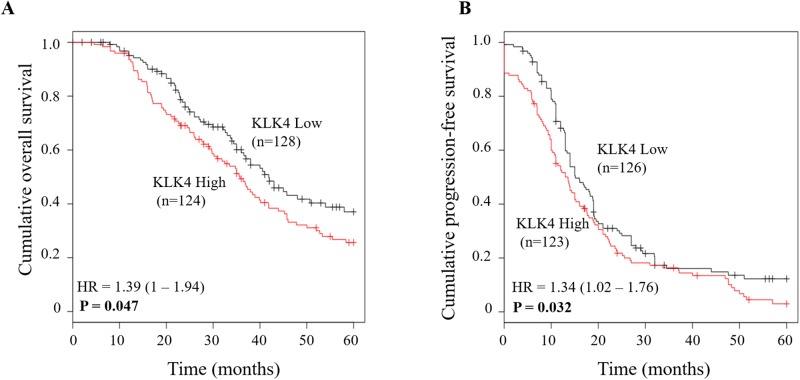
Validation of significant associations between KLK4 mRNA expression and patient outcome in a publicly available Affymetrix microarray data set.The microarray data set analyzed for KLK4 mRNA expression (probe ID 1555737_a_at) was from The Cancer Genome Atlas (TCGA). The patients were selected for serous histological type, advanced stage (FIGO III/IV), high-grade (grade 3), platinum-containing chemotherapy, and 5 years’ follow-up. This selection resulted in a patient cohort encompassing 252 patients for analysis of the association with OS (A) and 249 patients for PFS (B), respectively.